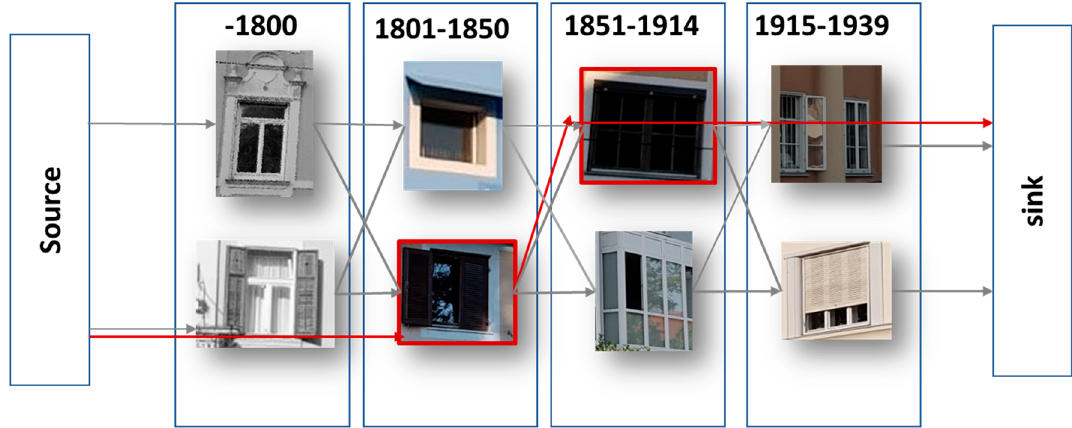
Figure 8. Sample chain graph (our own redrawing). Elements in adjacent periods are fully connected with weights depending on their co-occurrence, while the source and sink connect to every node with weights that penalize the number of skipped periods. Here, the shortest path (in red) skips pre-1800 and 1915–1939 because they lack the long balconies of the other periods. (For clarity, this visualization shows only four periods (instead of ten), and only some source and sink edges [38]).